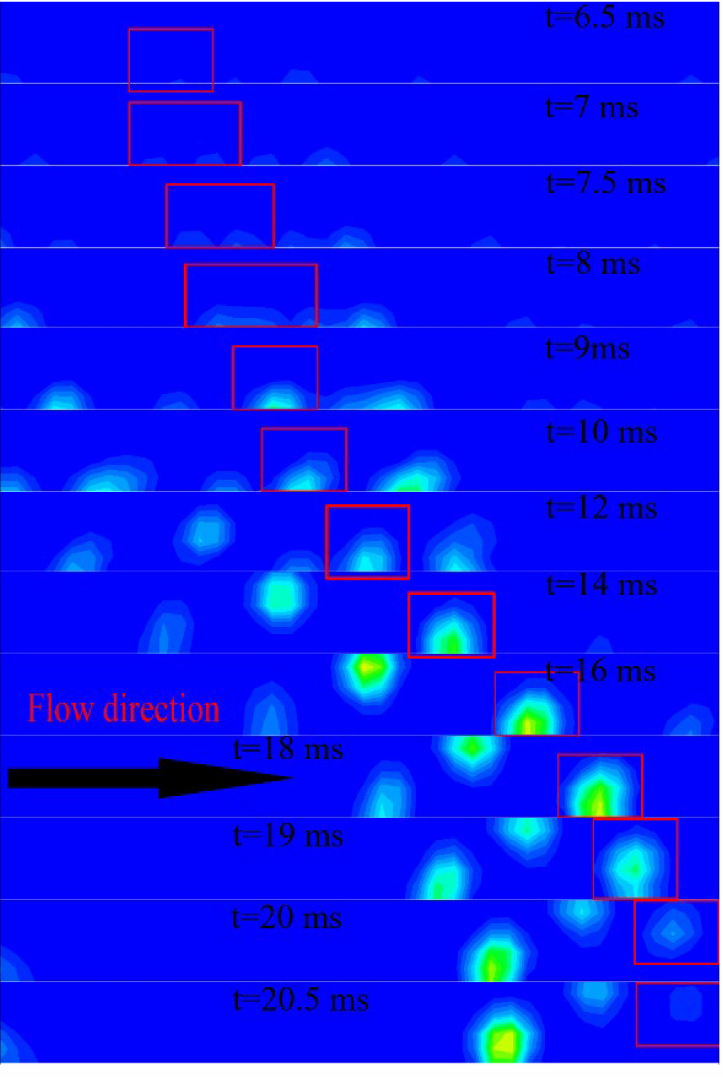
Figure 6. The developing process of coalescing bubble with